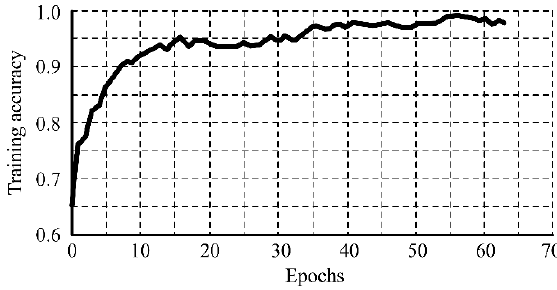
Figure 8. CNN accuracy during training.